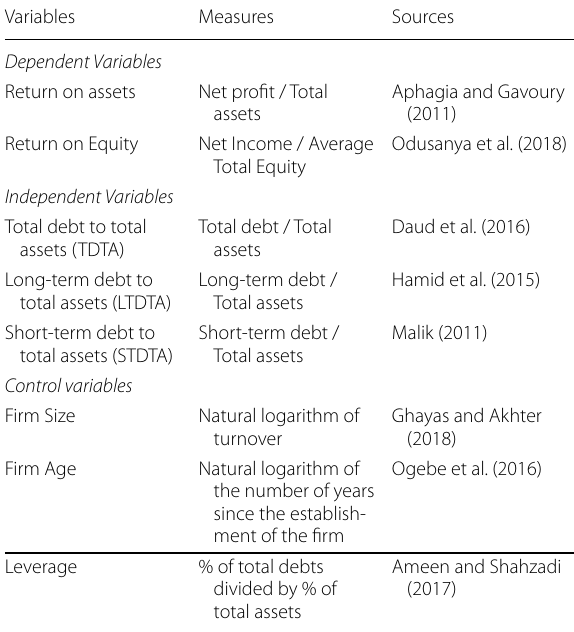
Variable Mean Median Maximum Minimum ROA